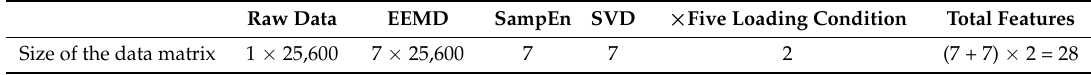
Table 4. Number of extracted features in C 1 to C 6 signal.